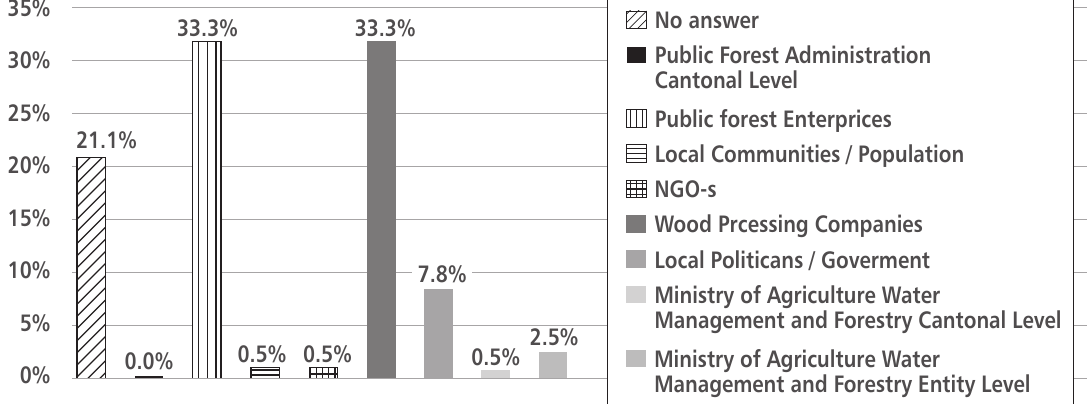
FIGURE 5 Organizations involved in the